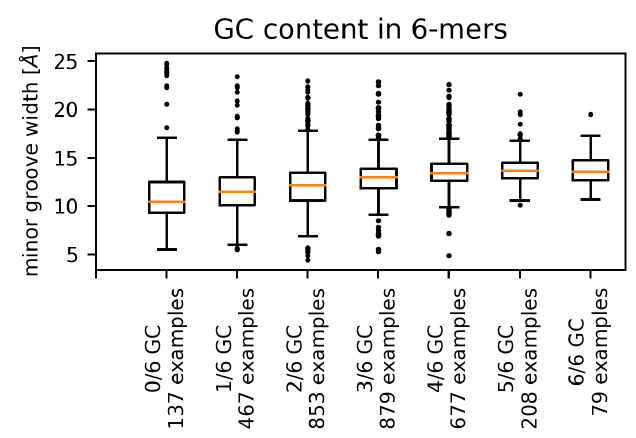
Figure 5. Distributions of DNA minor groove widths corresponding to hexamers with different values of GC content (complete non-redundant dataset). The numbers of examples refer to the number of hexamers with said GC content.